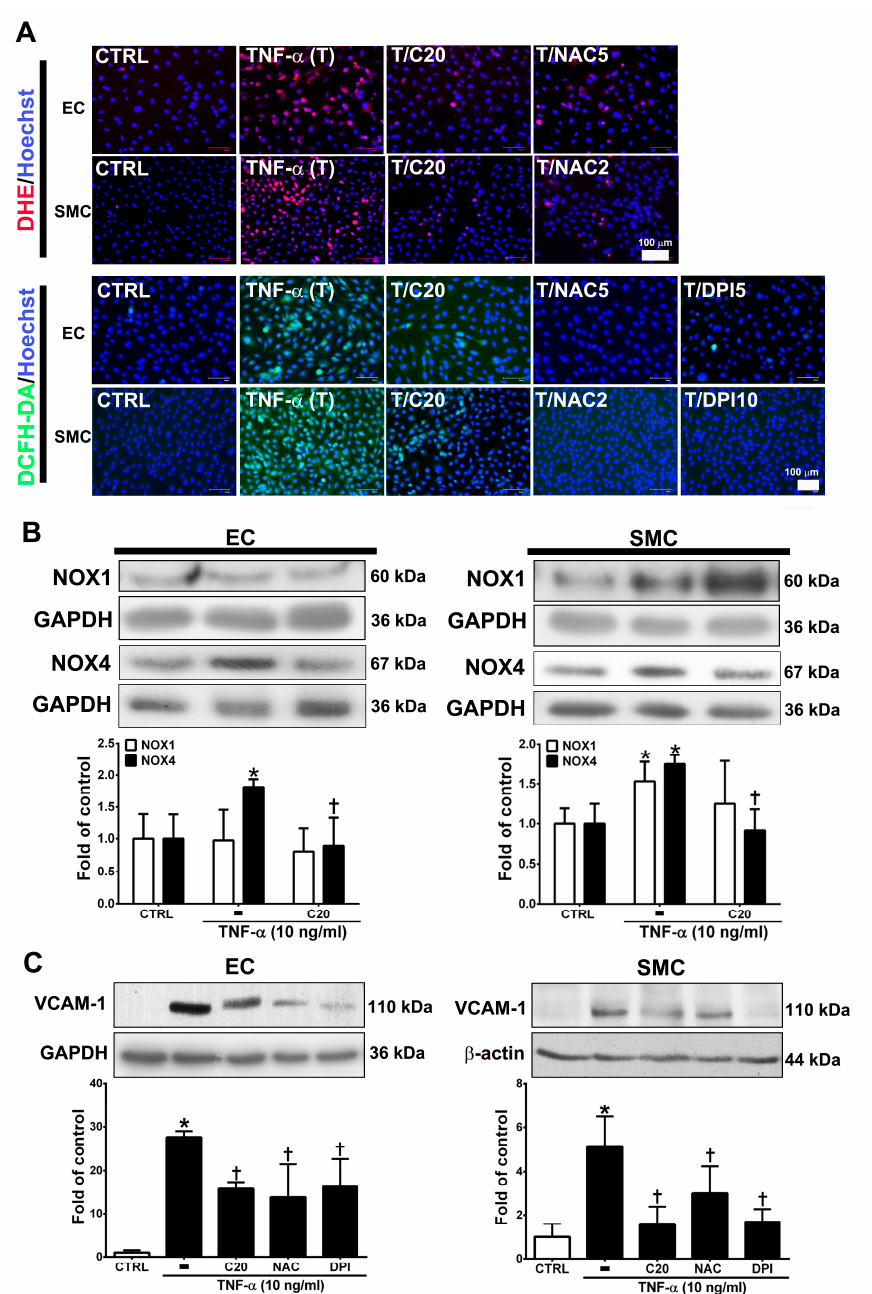
Figure 2. Corylin reduces VCAM-1 expression in TNF- α -treated HUVECs and VSMCs through reactive oxygen species (ROS) inhibition. ( A ) HUVECs and VSMCs were treated with 20 µ M corylin (C20), 2 or 5 mM NAC (NAC2 or 5), and 5 or 10 µ M DPI (DPI5 or 10) and then treated with 10 ng / mL TNF- α (T) for another 30 min or 3 h. The treated cells were stained with H 2 DCFDA or DHE. The intracellular ROS levels were monitored by fluorescence microscopy. Nuclei were labeled with Hoechst (blue). ( B ) HUVECs and VSMCs were pretreated (1 h) with corylin (C20) and then treated with 10 ng / mL TNF- α (T) for 6 h. Western blot analysis and quantification of NOX1 and NOX4 protein expression. ( C ) HUVECs and VSMCs were treated with 20 µ M corylin (C20), 2 or 5 mM NAC, and 5 or 10 µ M DPI and then treated with 10 ng / mL TNF- α (T) for 24 h. Western blot analysis for VCAM-1 and quantification of VCAM-1 to GAPDH or β -actin in HUVECs or VSMCs. * p < 0.05 versus the untreated group (CTRL). † p < 0.05 versus the TNF- α -treated group. Scale bars = 100 µ m ( A